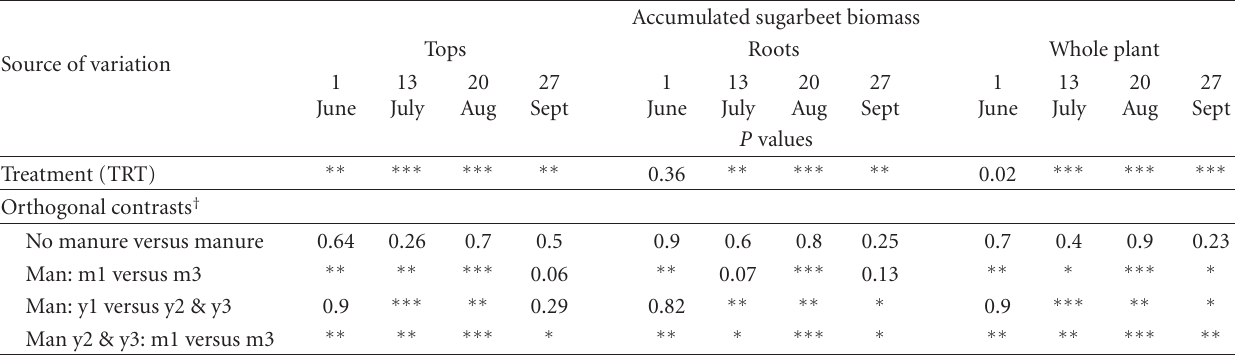
† No manure: NEFert + control + Fert; Man: manure = m1 + m3 where m1: manure-1x; m3: manure-3x; y1, y2, y3: fall manure applied 1, 2, and 3 years in the past, respectively.